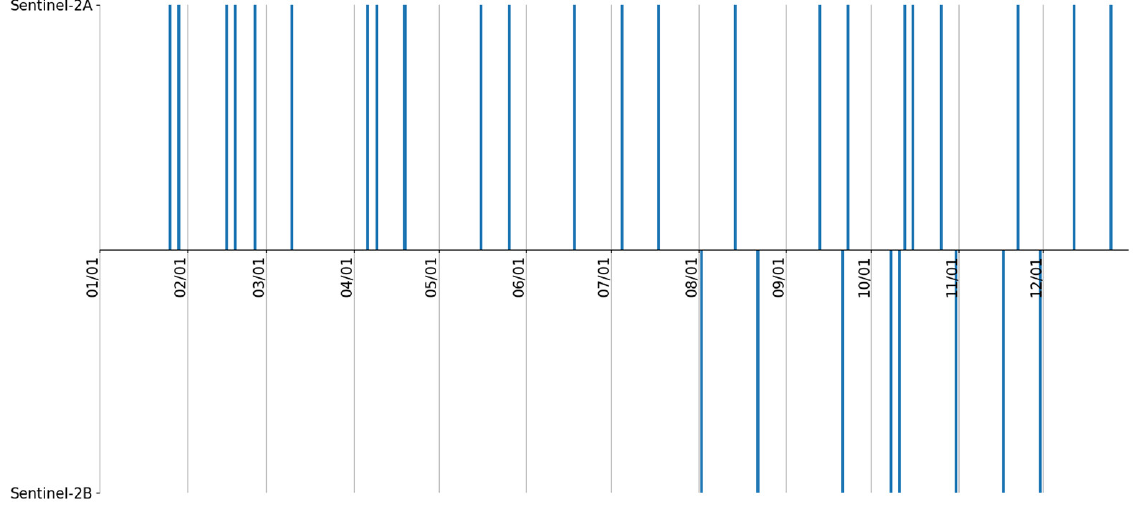
Figure 2. Dates of the Sentinel-2 time series acquired in 2017 (date format: MM/DD).